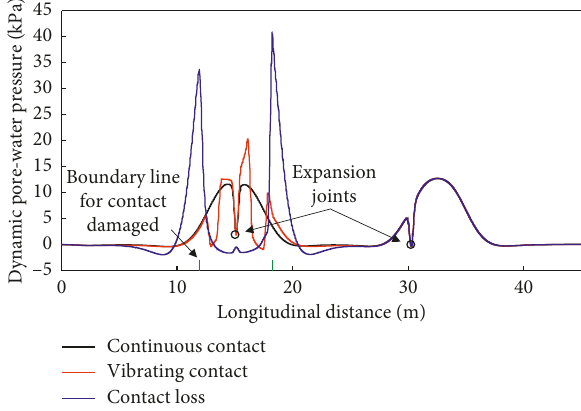
Figure 6: Dynamic pore-water pressure distribution of roadbed surface longitudinally in different contact